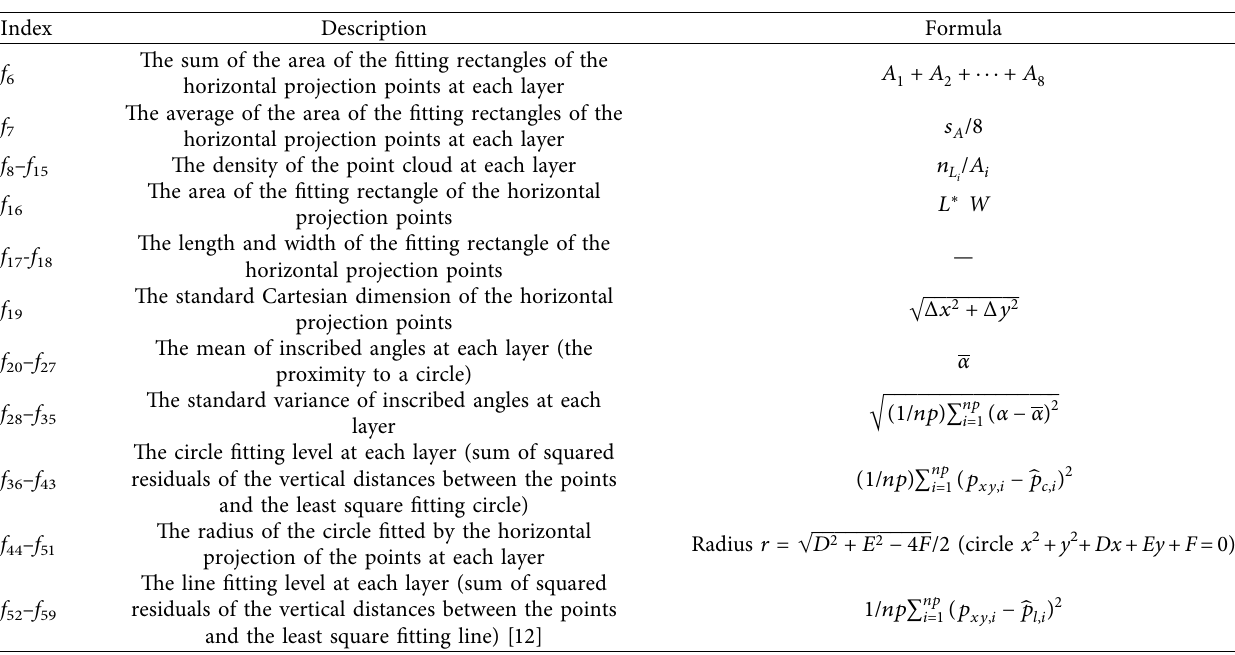
Table 2: Shape-based features.